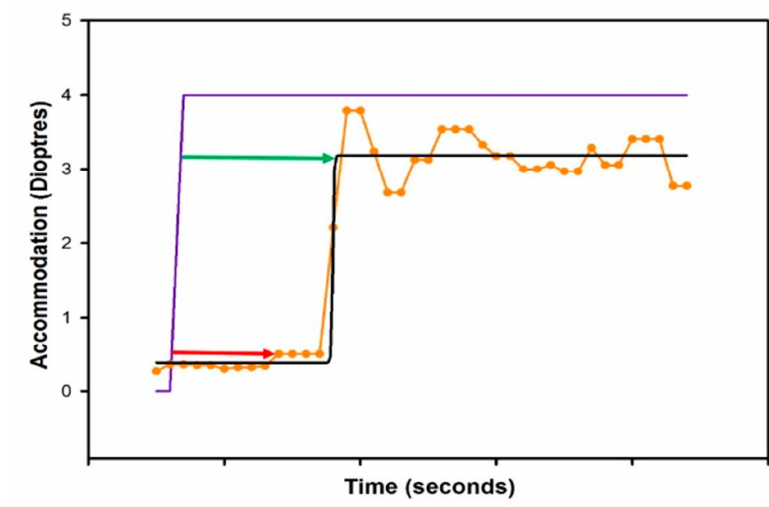
Figure 1. An accommodative dynamic profile of a pre-presbyope. The purple line represents the onset of the accommodative stimulus, the yellow line represents the accommodative response and the black line is the curve fitted to smooth the data. The red arrow demonstrates the latency of accommodation [28] and the green arrow represents the response times or time for accommodation/response time [24]. Table 2. The definitions and methods used to derive different time metrics from the accommodative dynamic profile.